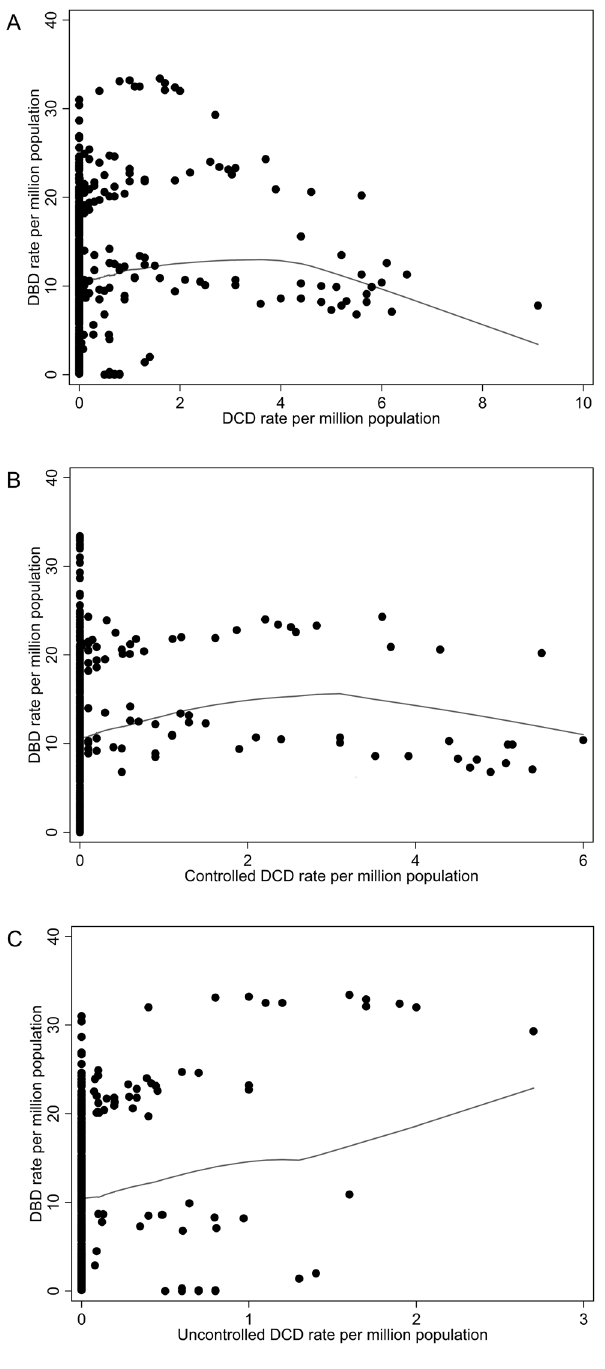
Figure 3. Donation after Brain Death (DBD) rates vs (a) Donation after Cardiocirculatory Death (DCD) rate (b) con- trolled Donation after Cardiocirculatory Death (cDCD) rate and (c) uncontrolled Donation after Cardiocirculatory Death (uDCD) rate. Solid lines are the Lowess curve of the predicted values from the fitted model.